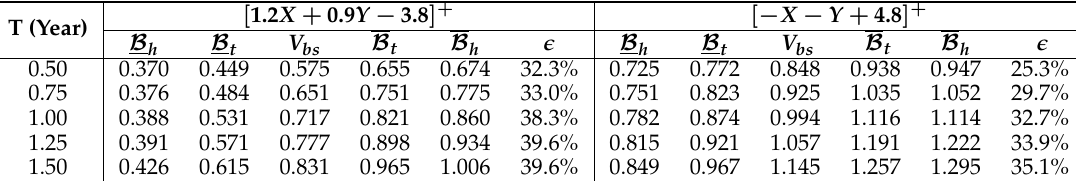
Table 3. Sensitivity of Valuation Bounds Against Maturity. The time-zero prices of the exchange rates X and Y are 1.6 and 2.5. The volatilities of the processes X and Y are 42%, and two processes are correlated with ρ = 0.20. Both the domestic and foreign interest rate are zero. All prices are attained within a price mesh of u = 1.12 and J = 30.